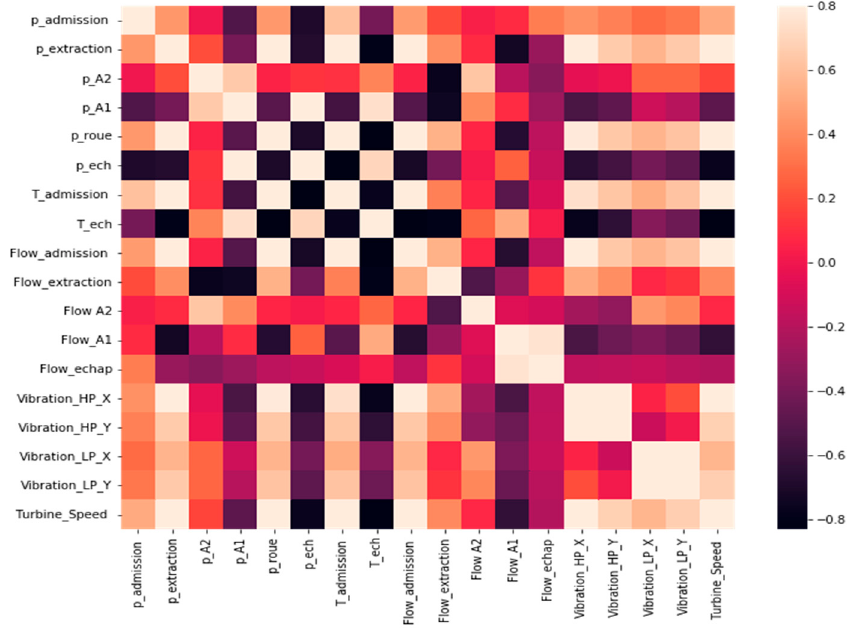
Figure 12. Correlation analysis of steam turbine parameters .